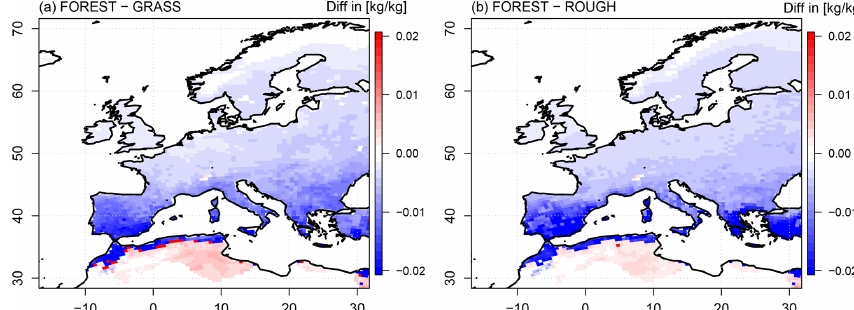
Figure 4. Differences in mean saturation deficit (in kilograms water vapor per kilogram wet air) between the vegetation and the atmosphere in summer between the FOREST and the GRASS experiments (a) and the FOREST and the ROUGH experiments (b) over the simulation period 1986–2015. The saturation deficit is calculated for the daily maximum surface temperature (top of